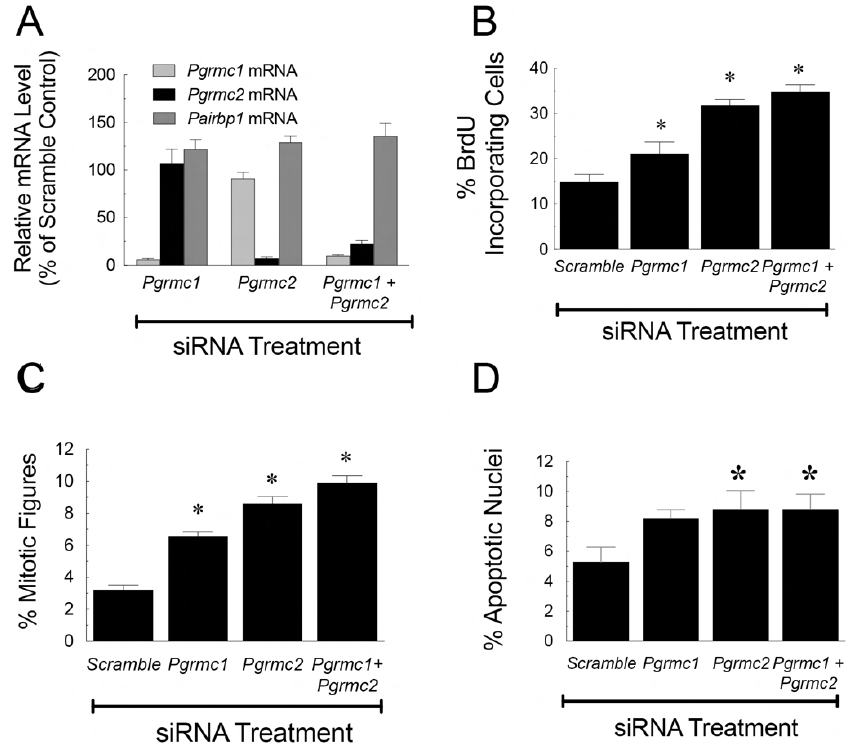
Figure 3. The effect of Pgrmc1 and/or Pgrmc2 siRNA treatment on the mRNA levels of Pgrmc1 , Pgrmc2 , and Pairbp1 ( A ); percentage of cells incorporating BrdU ( B ); percentage of cells arresting in metaphase ( C ); and the percentage of apoptotic nuclei ( D ). The values are means ± standard error. * Value in this and other figures is significantly different from scramble control ( p < 0.05). Data taken from Peluso et al. [71].